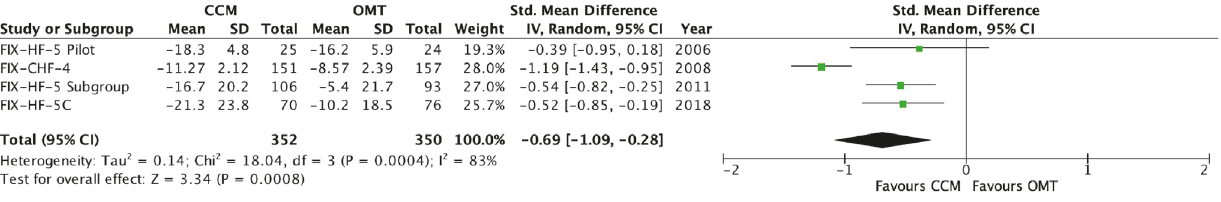
Figure 8: Forest plot of the MLWHFQ in the CCM groups versus the control groups. A forest plot of the data available to us from the 4 RCTs assessing MLWHFQ in those with CCM compared to those with OMT alone. There was a statistically significant difference between these two groups favoring